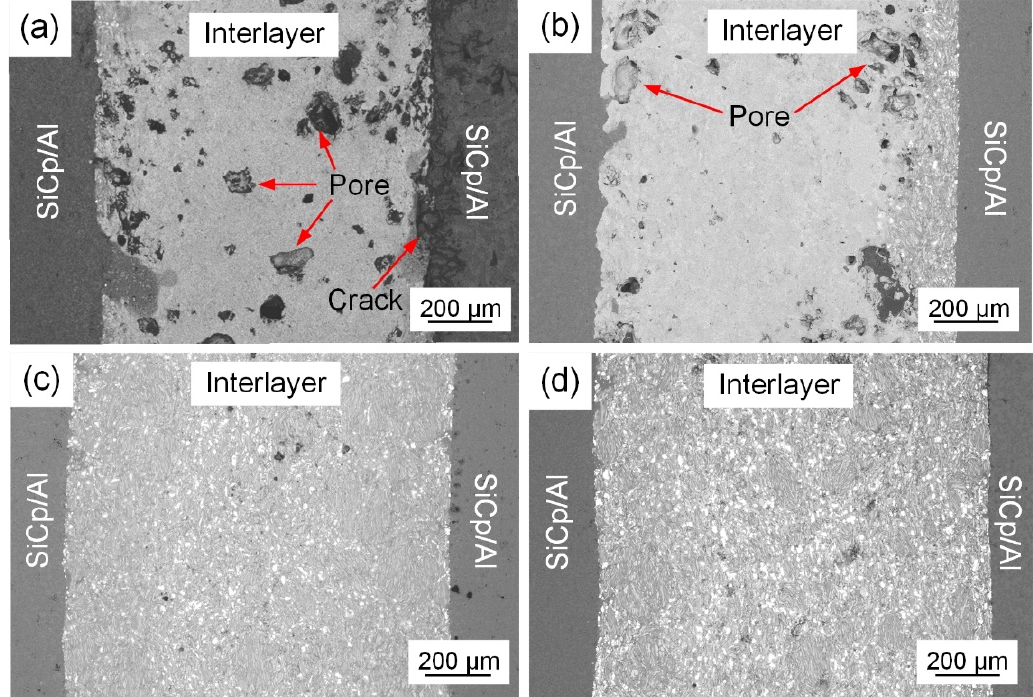
Figure 11. Microstructure of joints bonded using interlayers with different Zr contents. ( a ) 5 wt.%; ( b ) 10 wt.%; ( c ) 15 wt.%; ( d ) 20 wt.%.